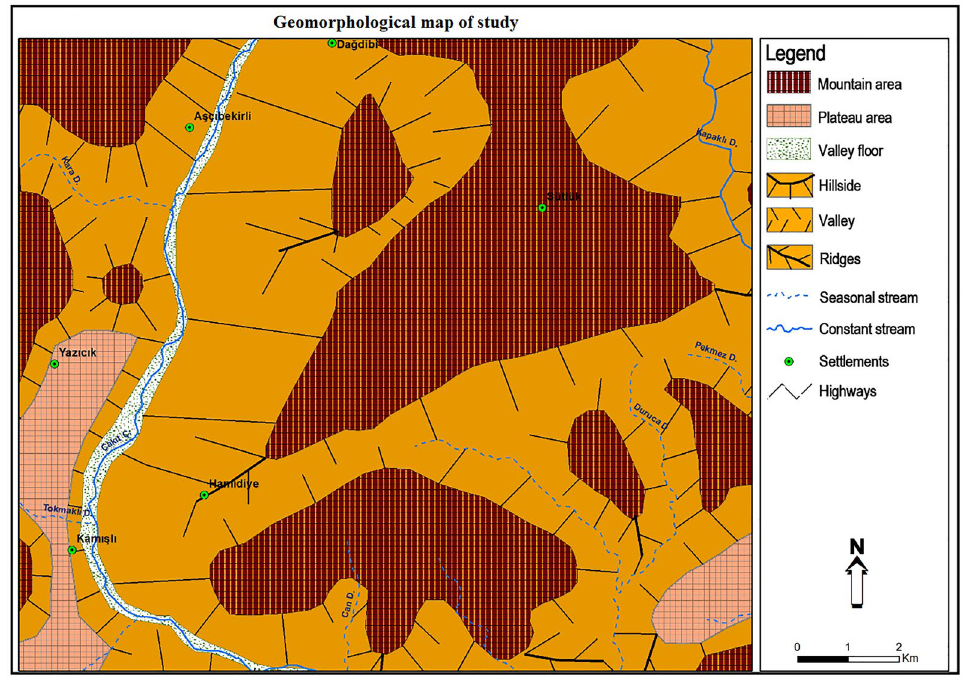
Fig. 5 Geomorphological map of study area